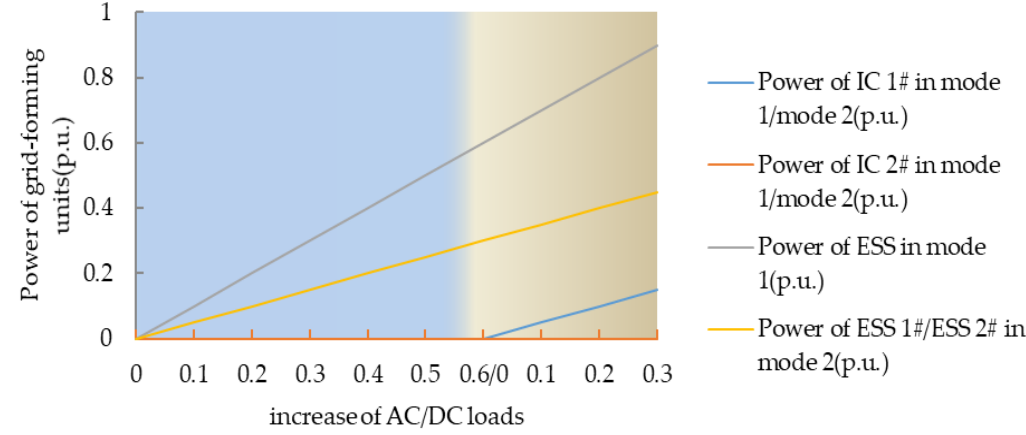
Figure 12. Distribution of the output power of the ESS / IC in IHMG for fluctuation AC / DC Figure 12. distribution of the output power of the ESS/IC in IHMG for fluctuation AC/DC load.